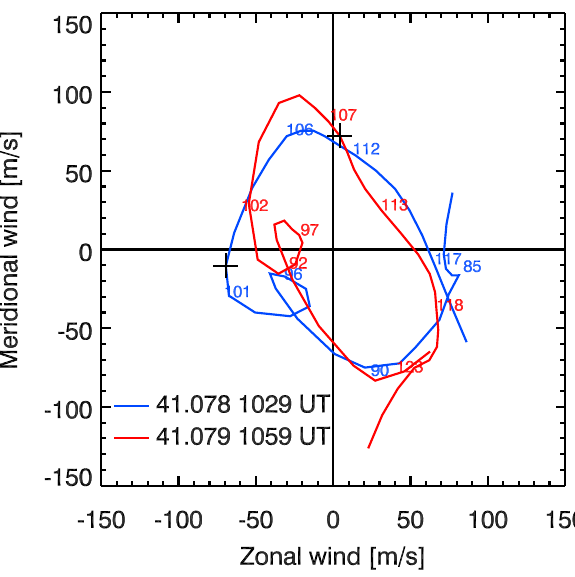
Fig. 4. Hodographs for flights 41.078 and 41.079. The numbers indicate altitudes in